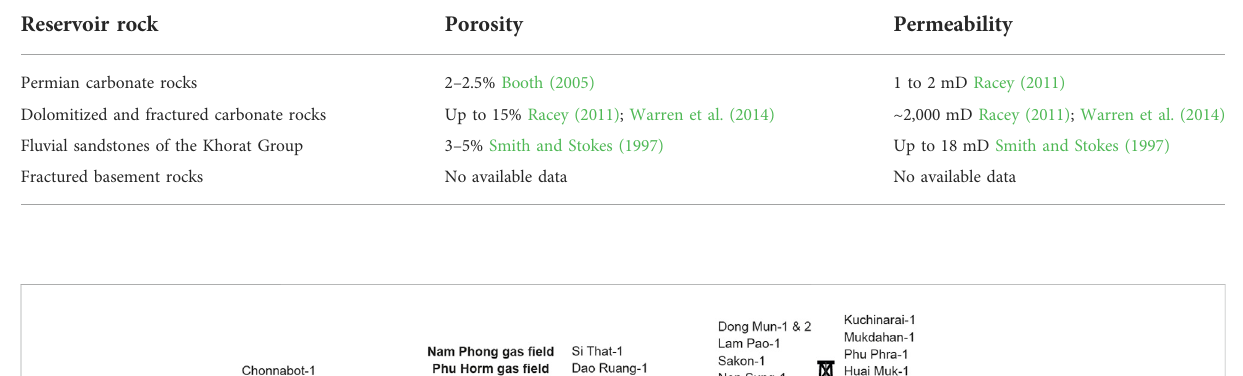
TABLE 1 The porosity and permeability of the potential reservoir rocks in the Khorat Plateau.